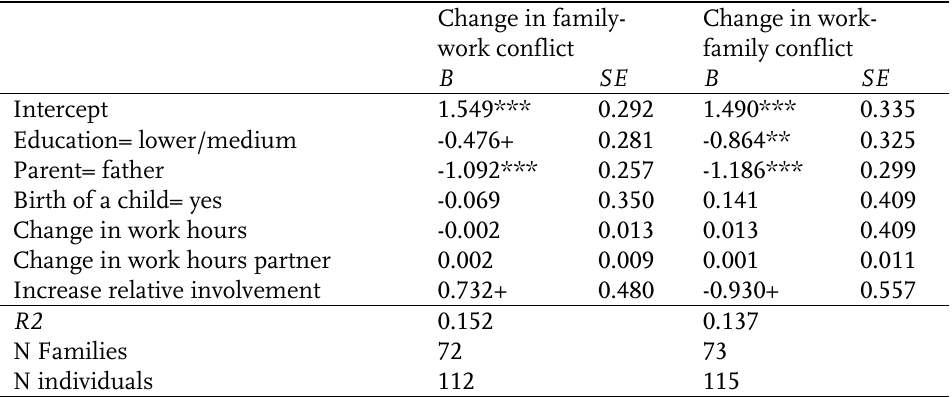
Table A.2b: Multilevel regression model on change in F → W-conflict and W → F-conflict, controlling for changes in relative involvement in childcare.